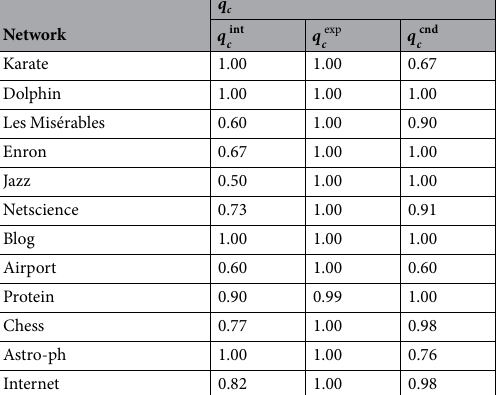
Table 4. Agreement between the ( q c , n c )–test and the ( q c , vol c